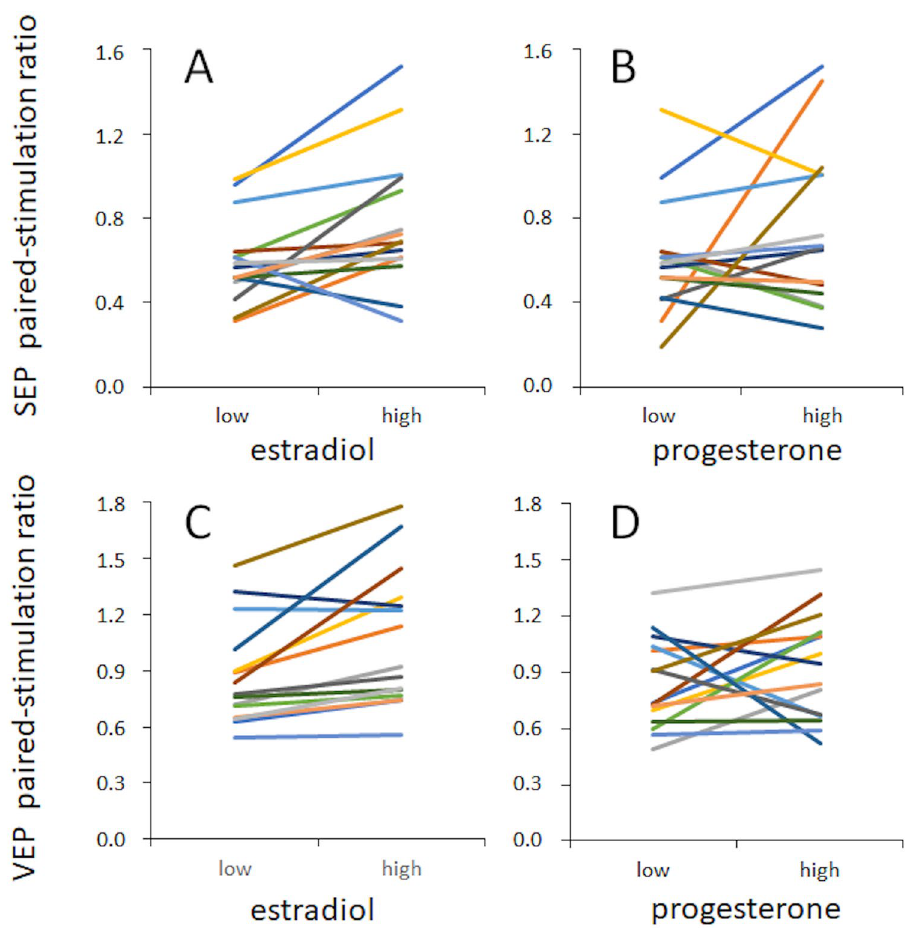
Figure 5. Individual paired-stimulation ratios. Paired-stimulation ratios of SEPs and VEPs recorded at the individual lowest and highest levels of estradiol ( A , B ) and progesterone ( C , D